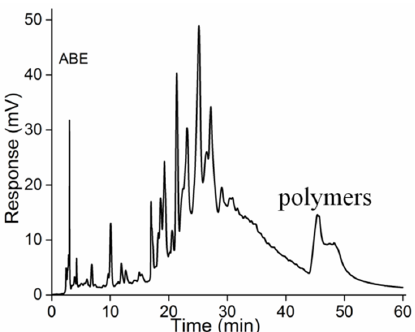
Figure 1. Representative normal-phase HPLC/Variable Wavelength Detector (VWD) chromatograms of PAs from ABE.